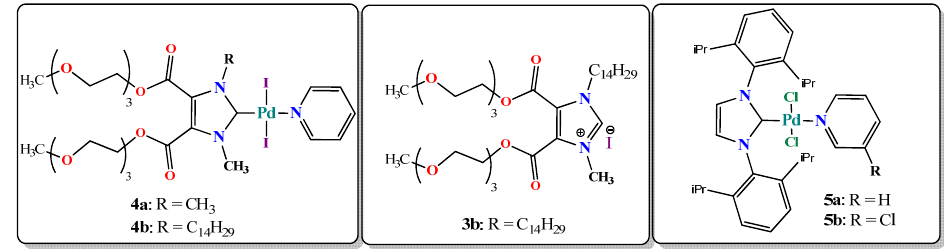
Scheme 3. Catalytic systems studied in test